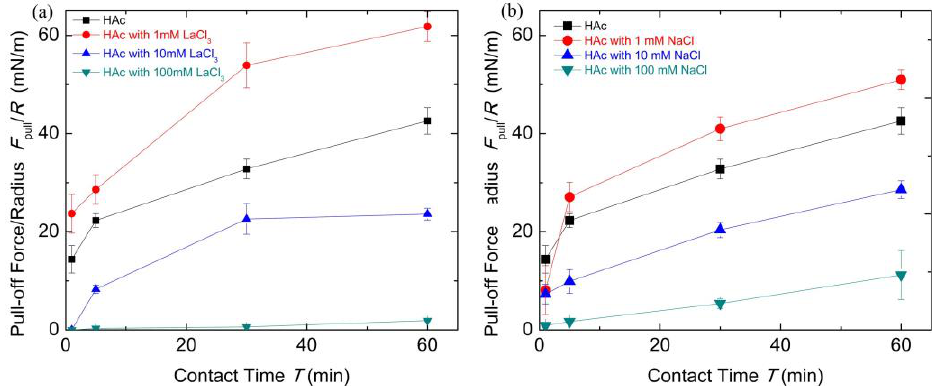
Figure 6. The pull-off forces F pull / R with contact time T under different salt solution conditions for chitosan films obtained from surface forces apparatus (SFA) measurements. ( a ) The HAc buffer with different concentrations of LaCl 3 ; ( b ) The HAc buffer with different concentrations of NaCl.